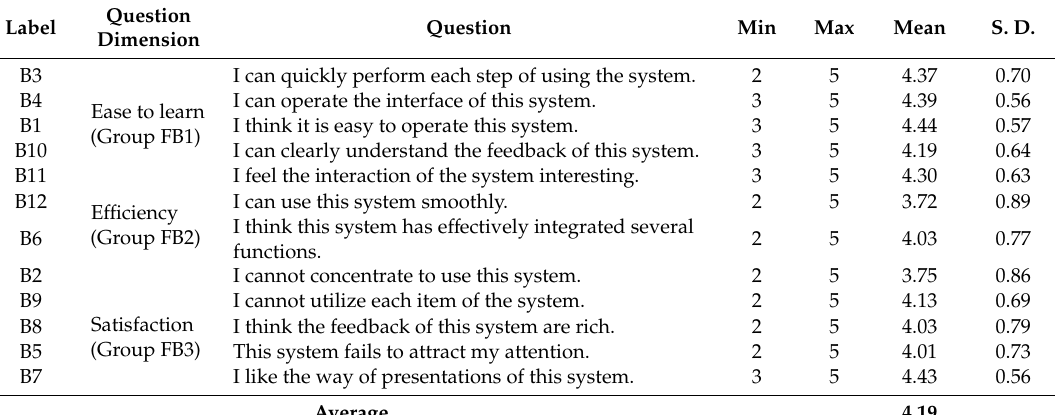
Table A4. Question dimensions (scales) and statistics of questionnaire data of the indicator of “system usability.”.